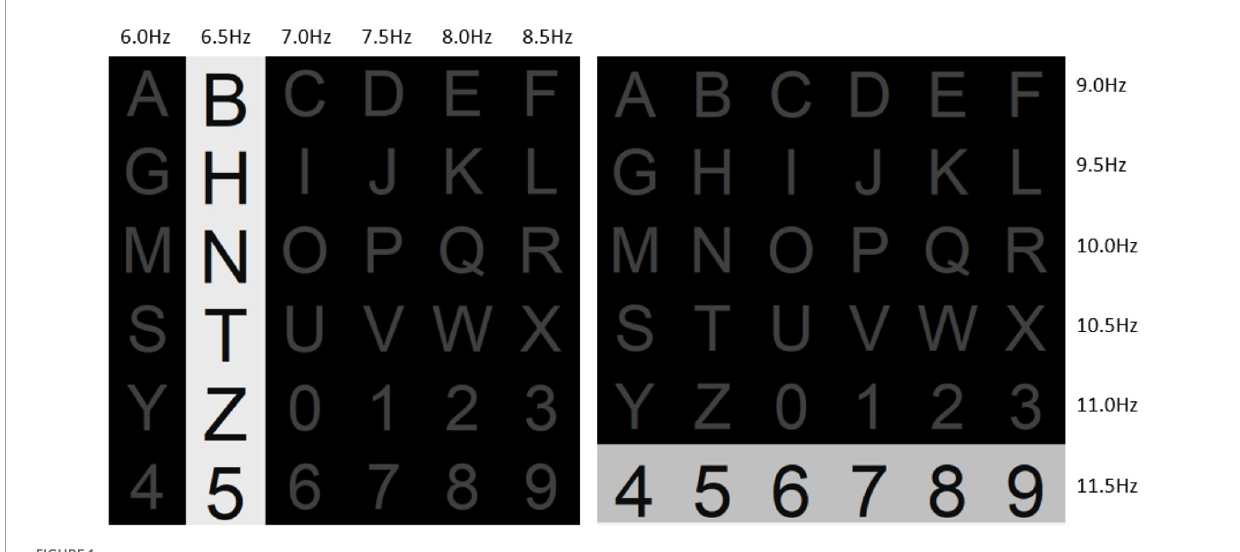
FIGURE1 The proposed frequency enhanced row and column stimulus paradigm. A flicker (white-black) with a specific frequency is assigned to one row or column of a 6 × 6 layout, and the row/column flashes are carried out in a pseudorandom sequence. In this figure, Column 2 and Row 6 are activated, and the target output is the number “5”.